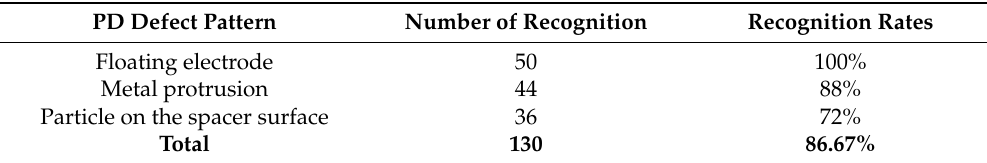
Table 4. Classification results of the SVM model in the chromatic space.